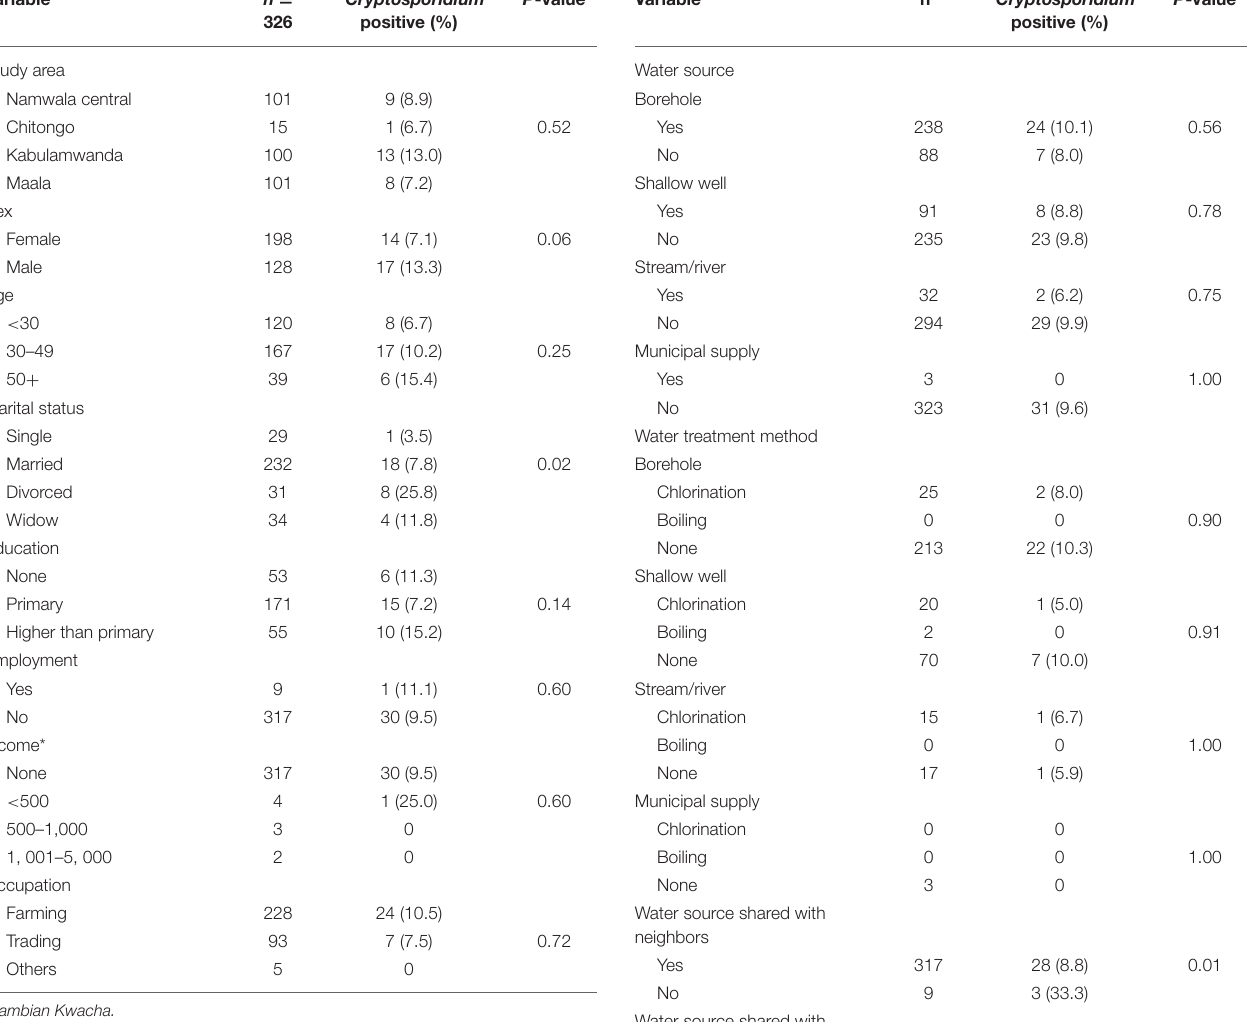
TABLE 1 | Association of Cryptosporidium infection and socio-demographic characteristics for the adult HIV positive population in Namwala district ( n = 326). Variable